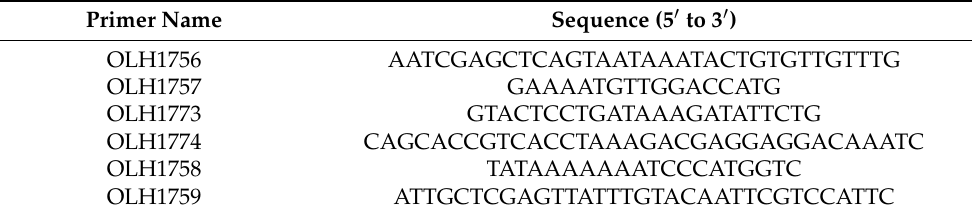
Table 1. Primers used to construct smk1 activation loop